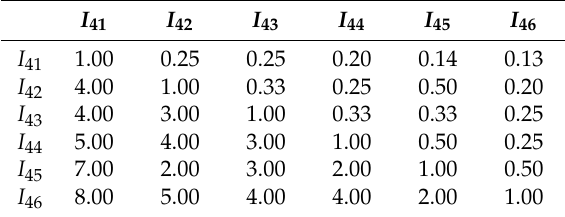
Table A5. Judgment matrix of the controlling process index.